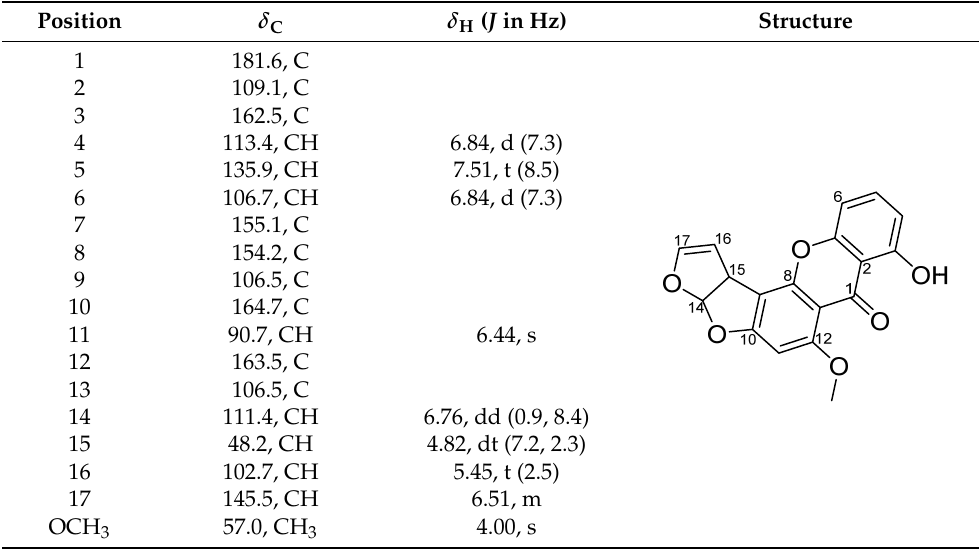
Table 2. 1 H NMR and 13 C NMR data of candidate ( δ in ppm, J in Hz, and NMR solvent Chloroform).